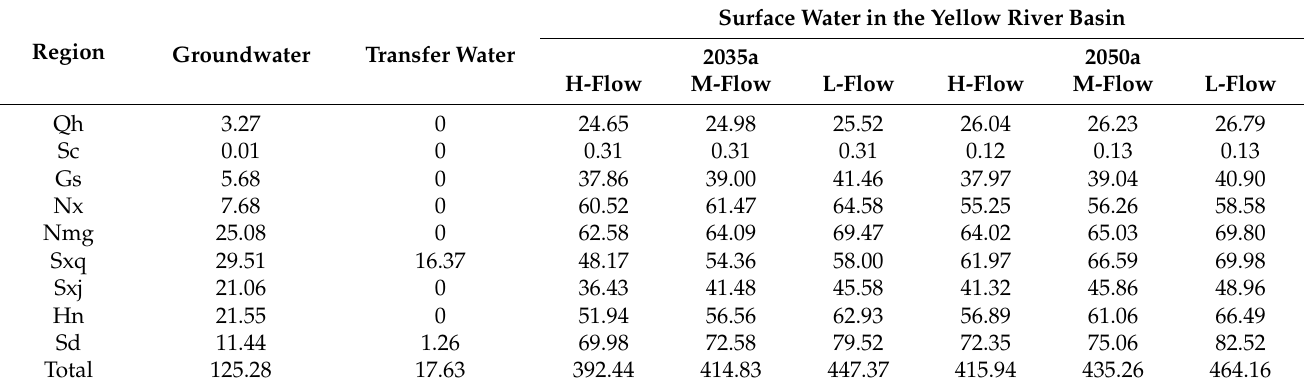
Table 4. Water resource allocation scheme for the Yellow River Basin in 2035a and 2050a. Unit: 10 8 m 3 .